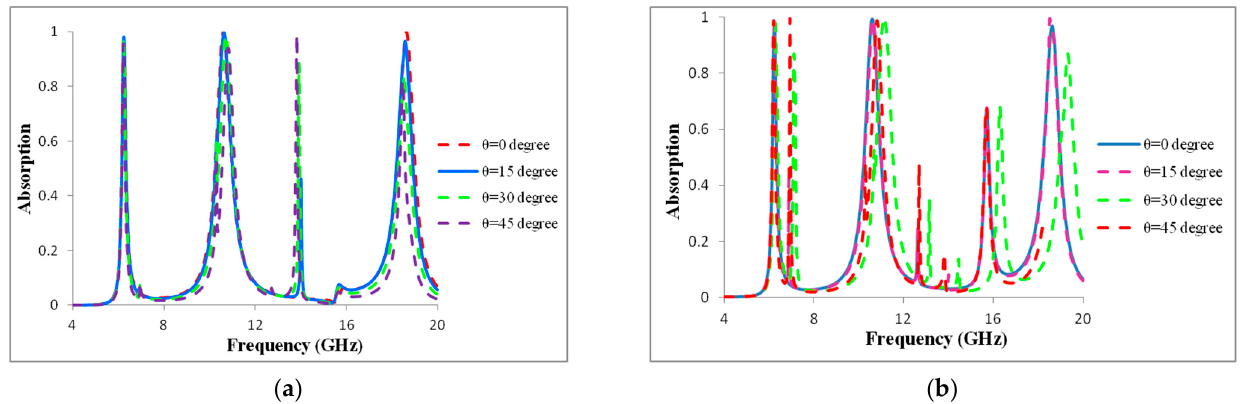
Figure 4. Absorption rate of different incidence angle ( a ) TE mode and ( b ) TM mode.